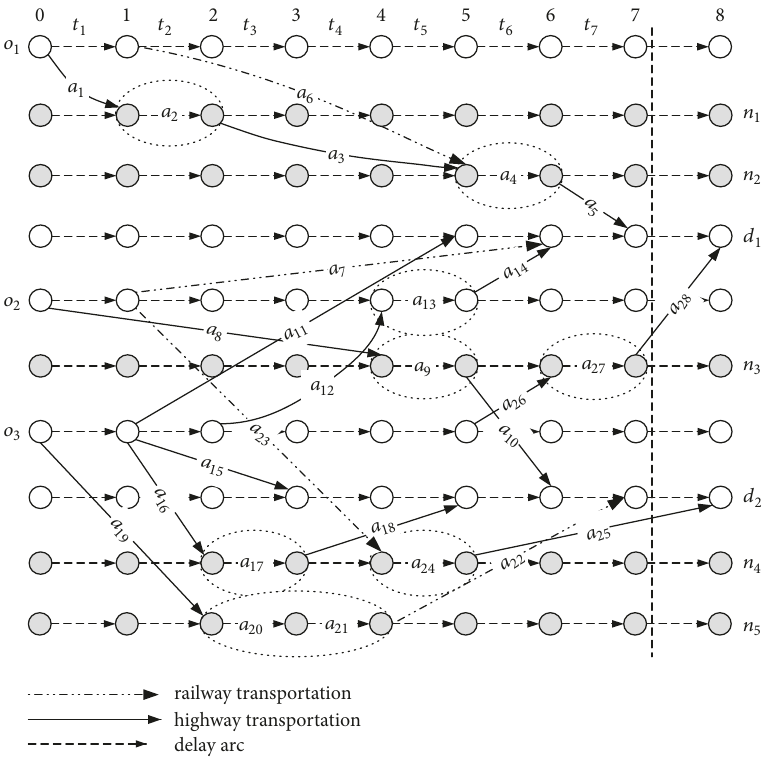
Figure 3: The initial time-space network of transportation.